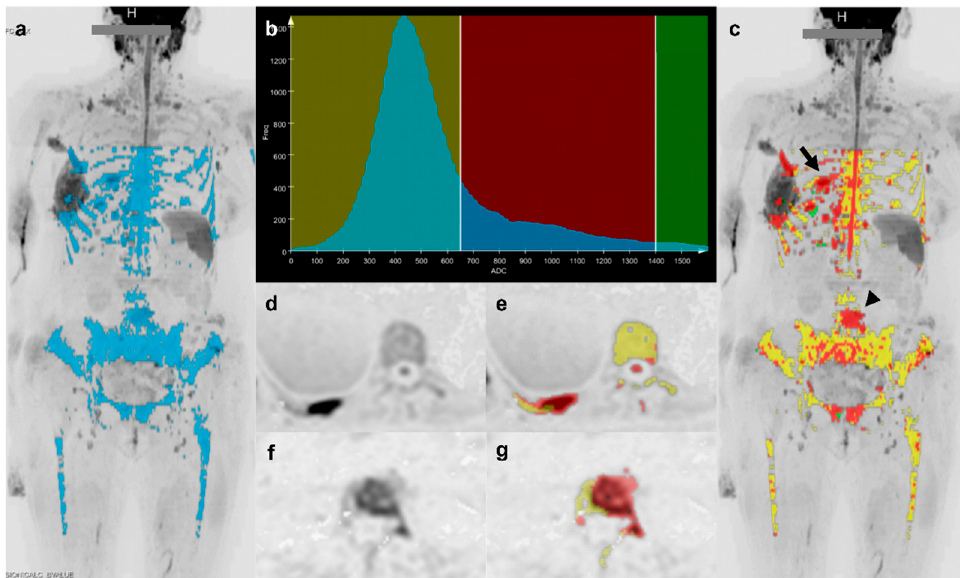
Figure 2. Extracting the bone metastases region of interest by applying apparent diffusion coefficient (ADC) thresholds to the bone marrow mask. Lesion segmentation started with the bone mask ( a ) seen overlaid on a coronal inverted gray-scale maximum intensity correction (MIP) being used to produce an ADC histogram ( b ) from the ADC data. The histogram was divided into three categories on the basis of two thresholds: below 650 µm 2 /s corresponding to normal bone (yellow band), between 650 µm 2 /s and 1400 µm 2 /s corresponding to lesions (red band), and above 1400 µm 2 /s corresponding to necrotic lesion or cyst (green band). The normal bone and bone lesion voxels identified in this way were then colorized as yellow and red, respectively, and overlaid on the coronal inverted gray-scale MIP ( c ) to show the localization of healthy bone and active disease. For two lesions (arrow and arrowhead in c ), axial high b -value diffusion-weighted images and the resulting separation of bone marrow (in yellow) from metastases (in red) shows: a lesion of the posterior arc of the 10 th right rib (arrow in c , d and e ); a lesion of the lumbosacral spine involving transverse process and part of the vertebral body (arrowhead in c , f and g ). Some residual soft tissues having ADC values in the considered range were included in the final evaluation (e.g., spinal cord in e ).